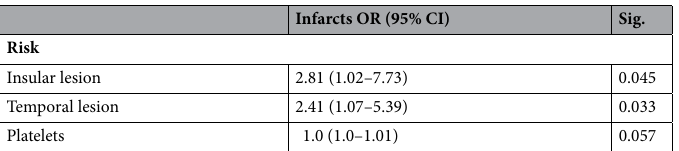
Table 2. Multivariate logistic regression analysis for estimating risk factors for intra-operative stroke. OR odds ratio, CI confidence interval.